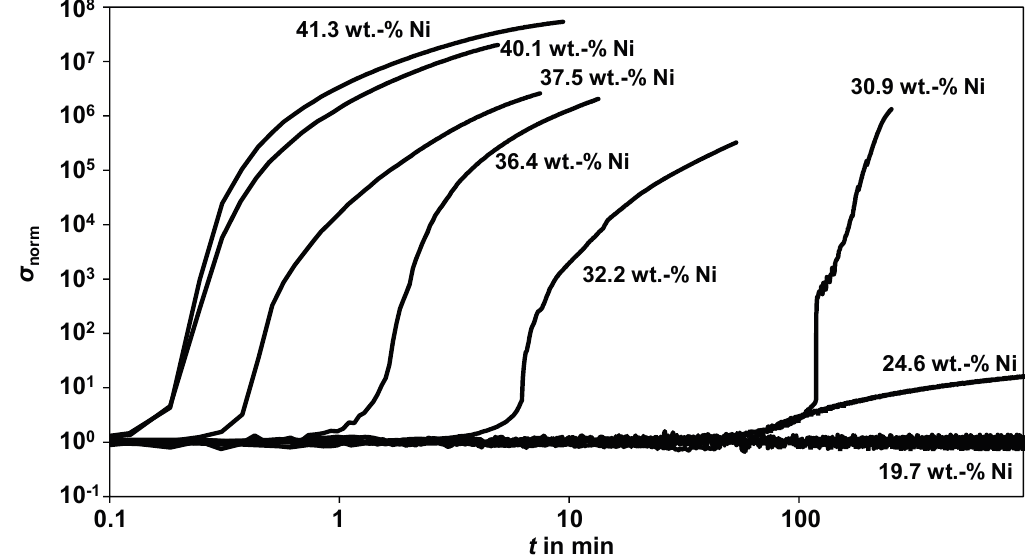
Figure 9. Normalized conductivity during sulfidation of self-prepared single catalyst pellets with different nickel contents. The curves from 0 wt% Ni to 32.2 wt% Ni were smoothed over 10 measurement points; Experimental data: T = 400 °C, 1000 ppm H 2 S in N 2 , V = 50 L · h − 1 (NTP), p = 1